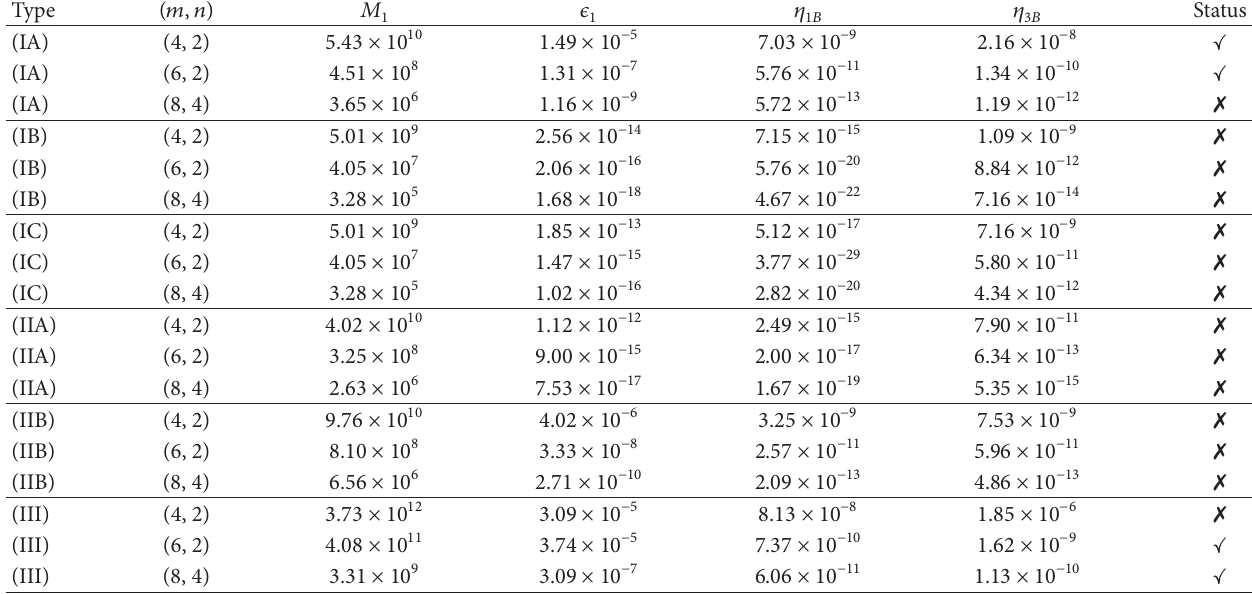
Table 2: For zero 𝜃 13 , the lightest RH Majorana neutrino mass 𝑀 1 and values of CP asymmetry and baryon asymmetry for QDN models (IA, IB, and IC), IH models (IIA, IIB), and NH models (III), with tan 2 𝜃 12 = 0.45 , using neutrino mass matrices given in Table 4. The entry ( 𝑚 , 𝑛 ) in 𝑚 𝐿𝑅 indicates the type of Dirac neutrino mass matrix taken as charged lepton mass matrix (6, 2) or up-quark mass matrix (8, 4), or down-quark mass matrix (4, 2) as explained in the text. IA (6, 2) and III (8, 4) appear to be the best models.